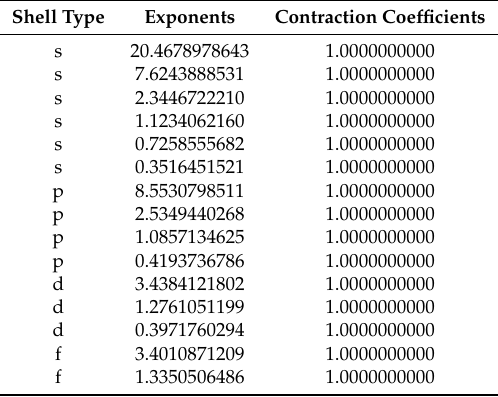
Table A20. Parameters of the cc-DZVP auxiliary basis set of Nitrogen. Parameters taken from